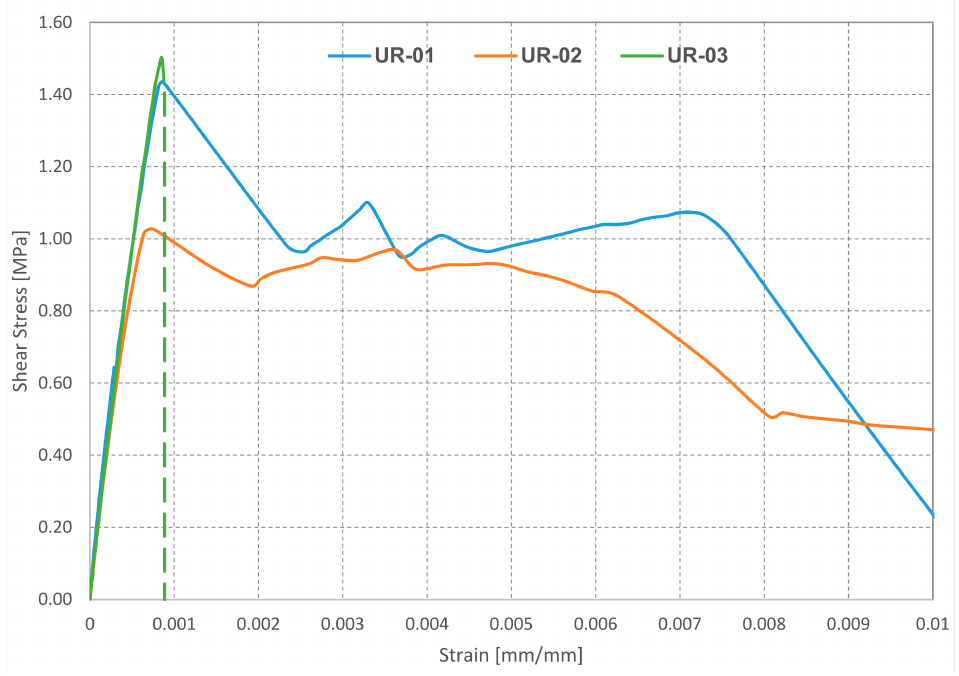
Figure 9. Shear stress vs. shear strain response of unreinforced wallettes under diagonal compression test (dotted line represents abrupt deformation without interim readings due to the sudden cracking and splitting apart of the two parts).